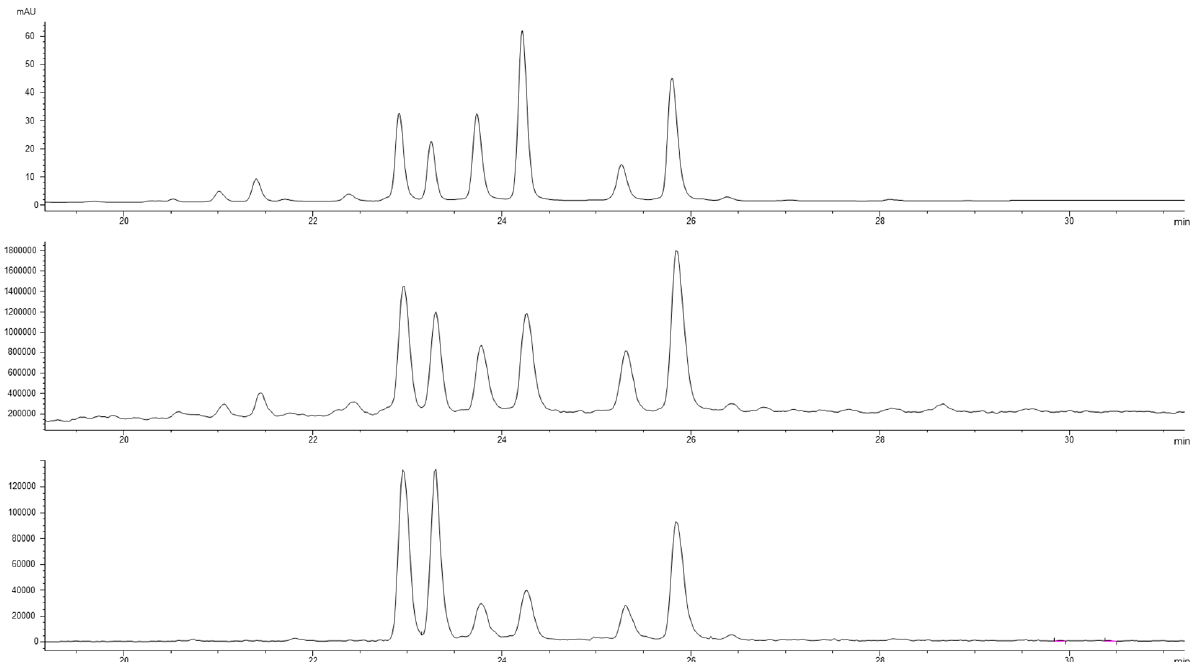
Figure 2. Chromatographic profiles at 350 nm of the SFE1 sample with the corresponding total ion current in the negative ionization mode and the EI at 315 m / z corresponding to the aglycone for the isorhamnetin derivatives; ( 1 , 2 ) quercetin 3-O glucosides; ( 3 , 4 ) isorhamnetin 3-O glucorhamnosides; ( 5 , 6 ) isorhamnetin 3-O glucosides; ( 7 , 8 ) isorhamnetin acetyl hexosides.